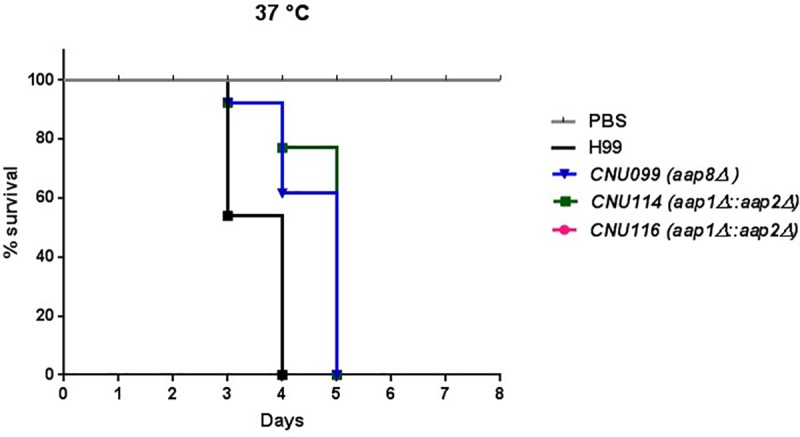
Animal model of infection in G. mellonella.The larvae were inoculated with the wild type (H99), single mutants (aap6Δ and aap8Δ) or double deletion (aap1Δ/aap2Δ) at 37°C for 8 days. Survival was followed during the course of the infection. Mutants aap8Δ and aap1Δ/aap2Δ were hypovirulent when compared to wild type H99 (**** and ***, respectively). PBS is a negative control.